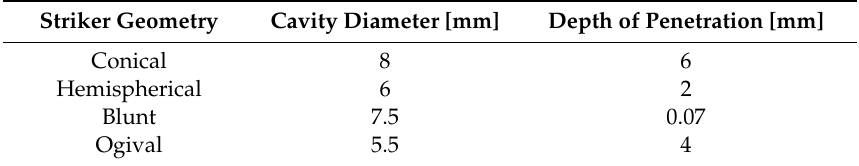
Table 6. Numerical results, depending on striker